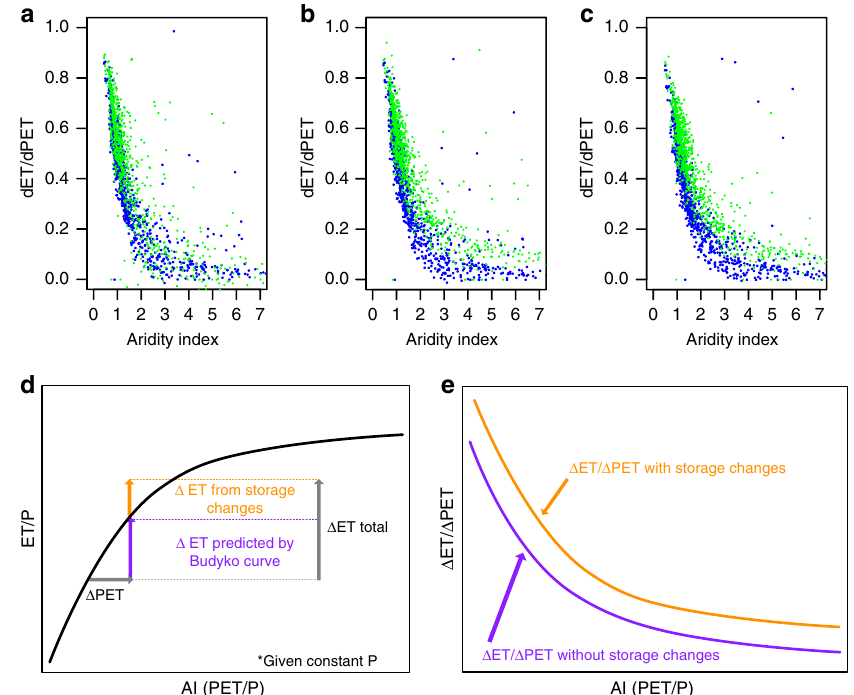
Fig. 5 Evapotranspiration sensitivity decreases as system warms and storage changes decrease over time. Scatter plots of the sensitivity to warming (change in evapotranspiration (ET) per change in potential evapotranspiration (PET)) versus aridity index for the fi rst (green dots) and fourth (blue dots) years of simulation for the 1.5 °C ( a ), 2 °C ( b ), and 4 °C ( c ) scenarios. The systematic decrease in sensitivity (i.e. downward shift) can be explained by storage changes increasing water availability relative to the Budyko framework for equilibrium systems ( d ). This storage contribution increases the system response for a given PET perturbation ( e